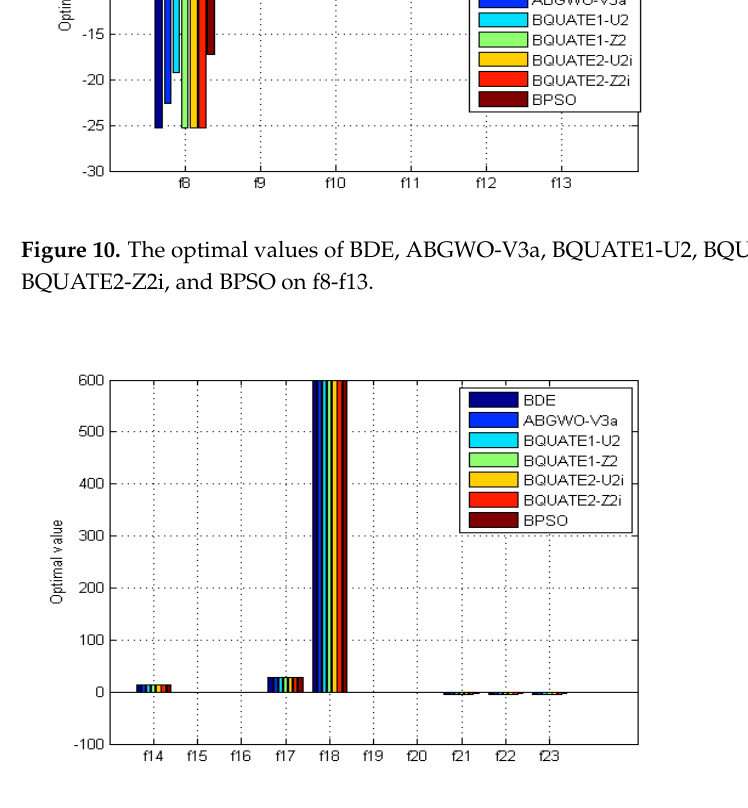
Figure 11. The optimal values of BDE, ABGWO-V3a, BQUATE1-U2, BQUATE1-Z2, BQUATE2-U2i, BQUATE2-Z2i, and BPSO on